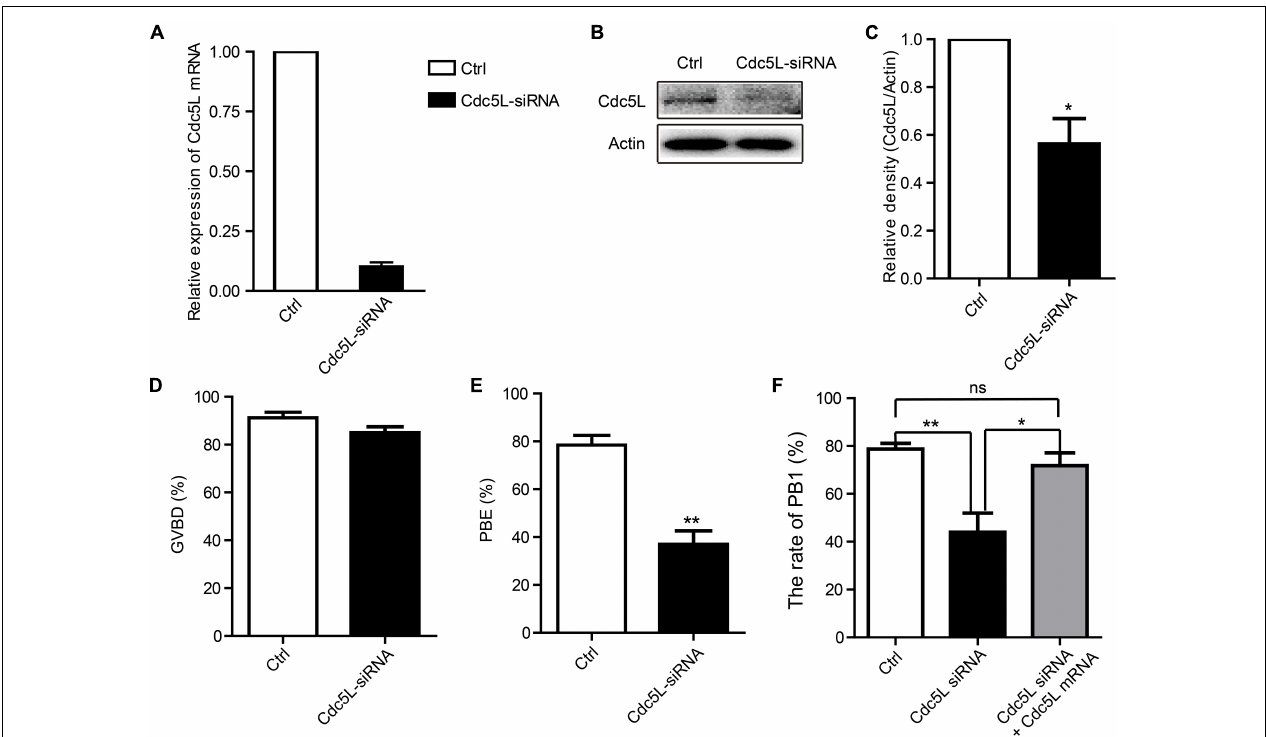
FIGURE 2 | Knockdown of Cdc5L reduces rate of PB1 extrusion. (A) Relative level of Cdc5L mRNA identified by RT–PCR in control and Cdc5L siRNA oocytes. A total of 50 oocytes were collected in each group after culture for 24 h in M2 medium with IBMX. At least three replications were conducted, and 150 oocytes were used for each group. Data are shown as means ± SEM. “*” represents P < 0.05; “**” represents P < 0.01. (B) Western blotting results for Cdc5L and β -actin in Cdc5L-siRNA injected oocytes and control oocytes after culture for 24 h in M2 medium with IBMX (150 oocytes per sample). At least three replications were conducted, and 450 oocytes were used for each group. (C) Relative staining intensity of Cdc5L assessed by densitometry. Data are shown as means ± SEM. “*” represents P < 0.05; “**” represents P < 0.01. At least three replications were conducted. (D) Percentages of GVBD were quantified in control and Cdc5L siRNA oocytes. Data are shown as means ± SEM. “*” represents P < 0.05; “**” represents P < 0.01. At least three replications were conducted. (E) Rate of PB1 extrusion was quantified in control and Cdc5L siRNA oocytes. Data are shown as means ± SEM. “*” represents P < 0.05; “**” represents P < 0.01. At least three